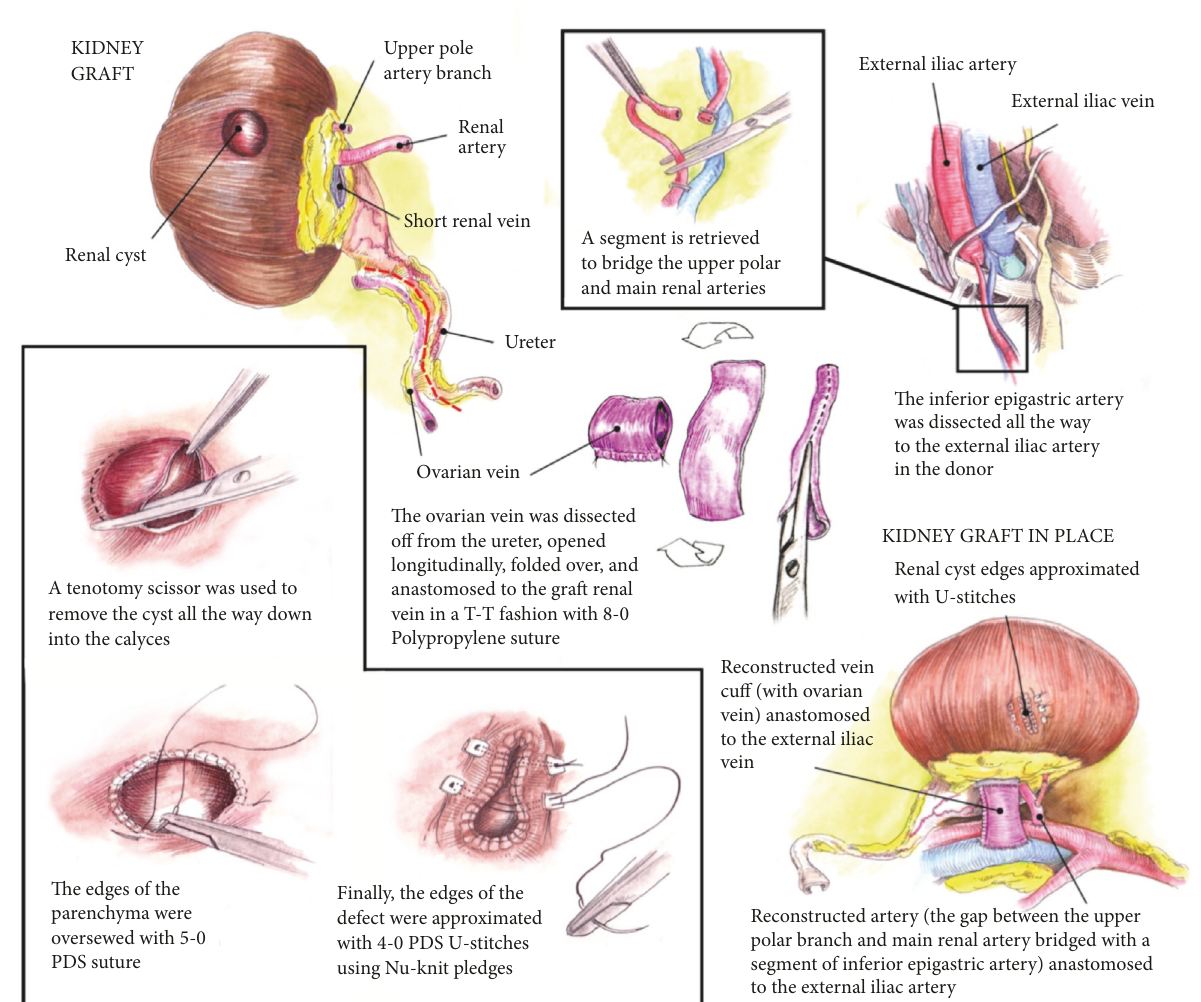
Figure 1: Schematic drawing describes the three surgical anomalies of the right donor